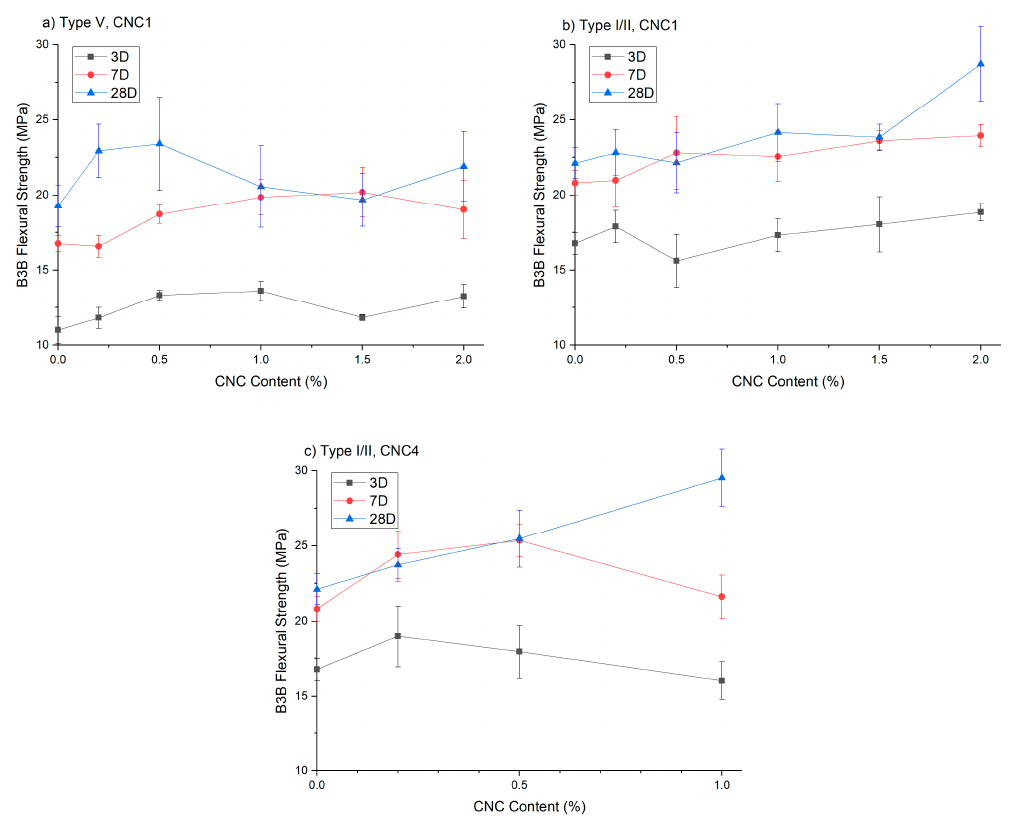
Figure 7. B3B flexural strength of cement with different CNC content: ( a ) Type V cement with CNC1; ( b ) Type I/II cement with CNC1; ( c ) Type I/II cement with CNC4.